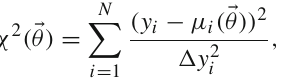
frame shows the position of the best-fit value which is the minimum of the χ 2 -function. The best-fit value of a Y is negative (case 1) in the left panels and positive (case 2) in the right